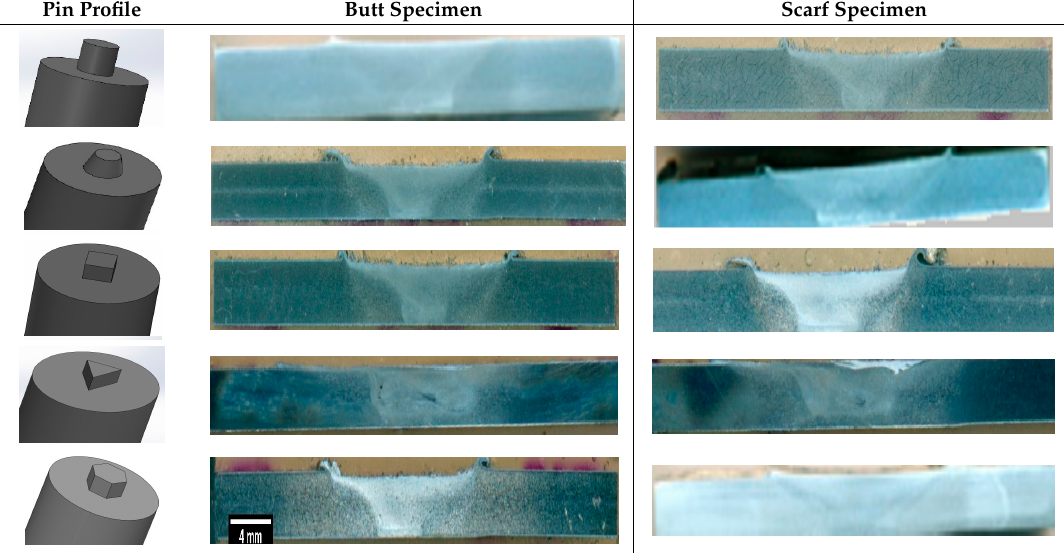
Table 3. Macrograph of friction stir (FS) welded butt and scarf joints showing different weld zones.